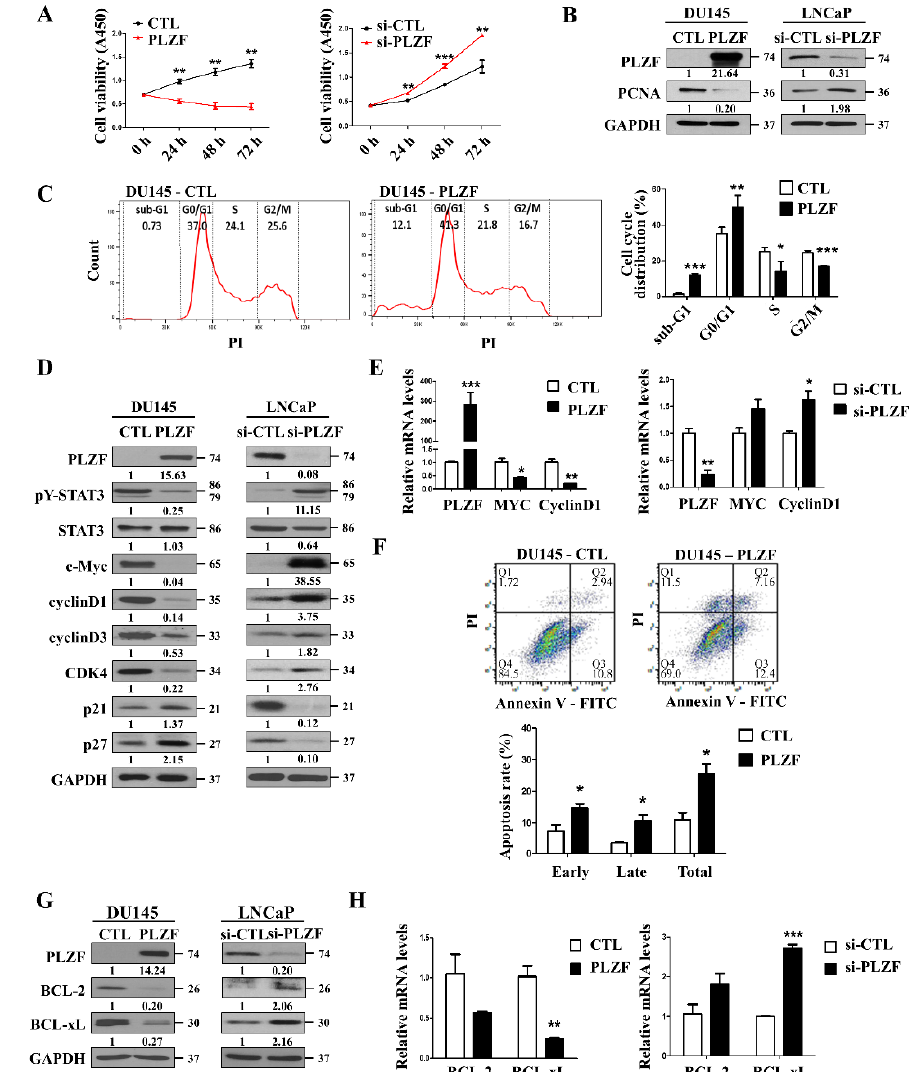
Figure 2. PLZF induces cell cycle arrest and apoptosis effects by suppression of STAT3 signaling. ( A ) CCK assay was performed by transfecting DU145 and LNCaP cells with plasmid and siRNA, followed by culture for 1 – 3 days. ( B ) Western blotting was performed in PLZF plasmid and siRNA-transfected cells. ( C ) Effect of cell cycle distribution of MOCK- and PLZF-transfected DU145 cells was detected by flow cytometry analysis. Representative histograms of cell cycle alteration. Summarized results from three independent experiments were quantified as mean ± SD (right). ( D ) Protein expression levels of indicated cell cycle regulators were detected by Western blotting. ( E ) mRNA expression levels of PLZF, MYC, and CyclinD1 were examined by qRT-PCR in DU145 and LNCaP cells transfected with PLZF plasmid and siRNA. ( F ) Apoptosis assay of PLZF plasmid and siRNA transfected DU145 and LNCaP cells was detected by Annexin V-FITC/PI staining. Representative histograms of cell cycle alteration. Summarized results from three independent experiments were quantified as mean ± SD (right). ( G ) Protein expression levels of indicated apoptosis regulators were detected by Western blotting. ( H ) mRNA expression levels of BCL2 and BCLxL were examined by qRT-PCR in DU145 and LNCaP cells transfected with PLZF plasmid and siRNA. In (A) and (B), data